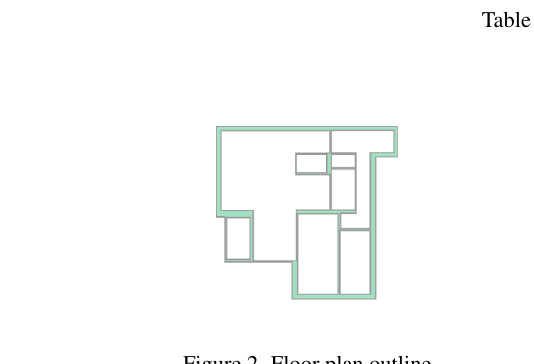
Table 2. Reference sizes in cm